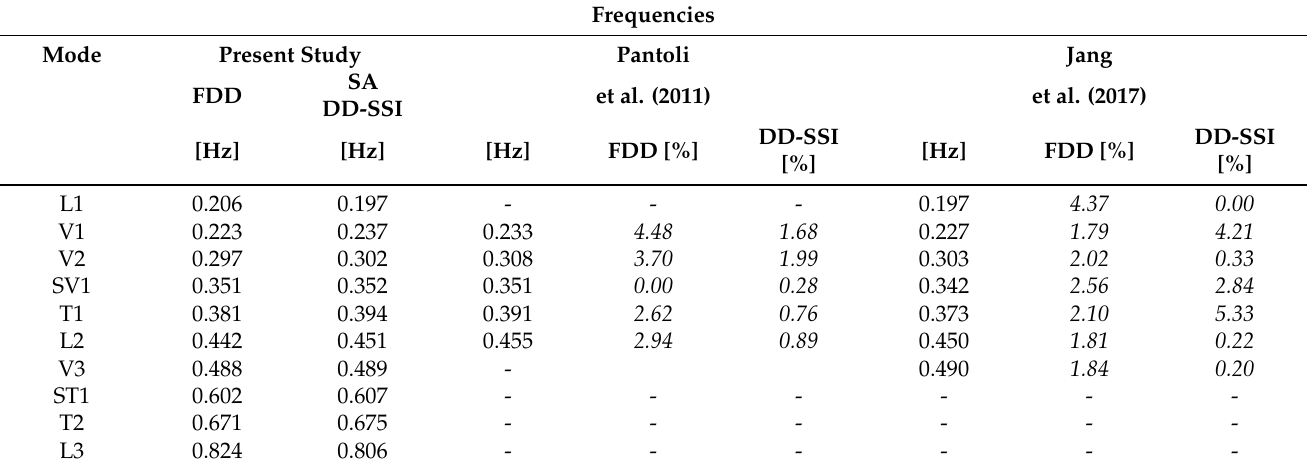
Table 2. Identified structural frequencies and comparison (percentage variation) with previous studies.